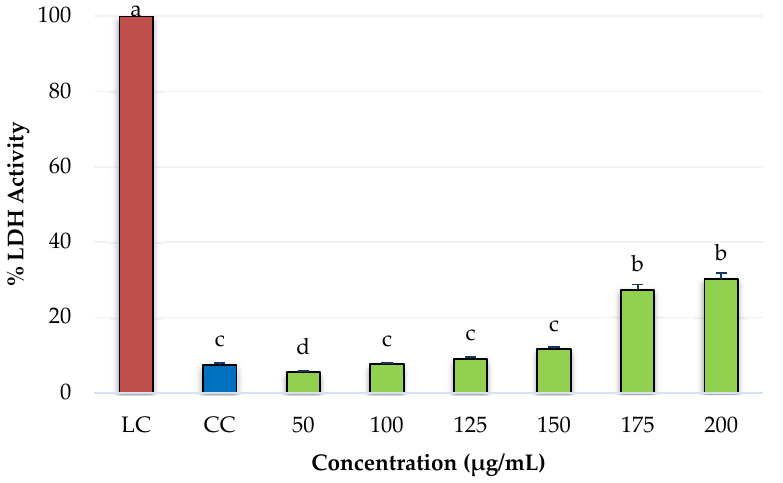
Figure 1. Cytotoxicity of PRE from H. pattens (HP), L. graveolens (LG), and L. palmeri (LP) on normal fibroblast cells (NIH3T3), expressed as a percentage of lactate dehydrogenase activity (LDH). LC (Lysis Control), CC (Cell Control). Values with a different letter are statistically different ( p ≤ 0.05). Results are expressed as means (n = 3) ± standard deviation (bars).